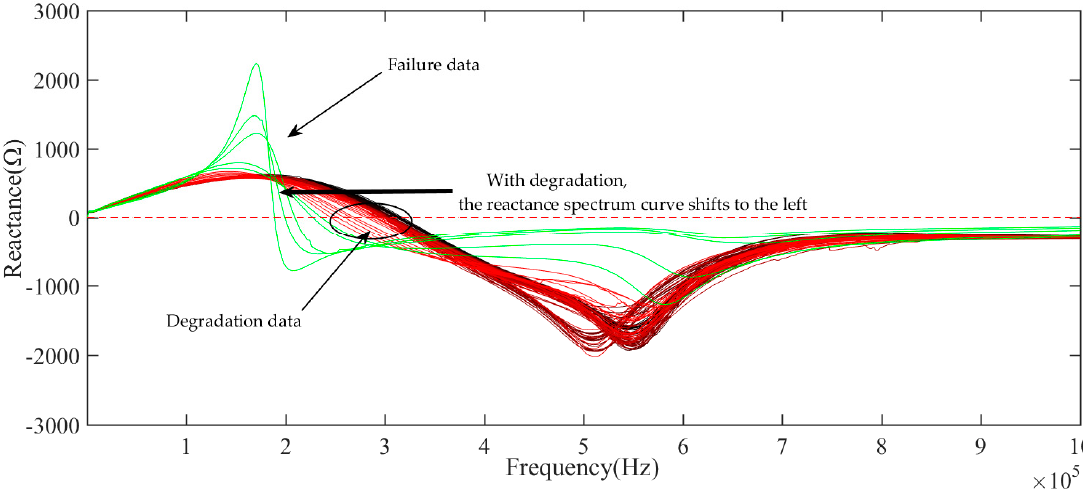
Figure 7. The measurement value of Reactance spectra of the electromagnetic coil with aging time.